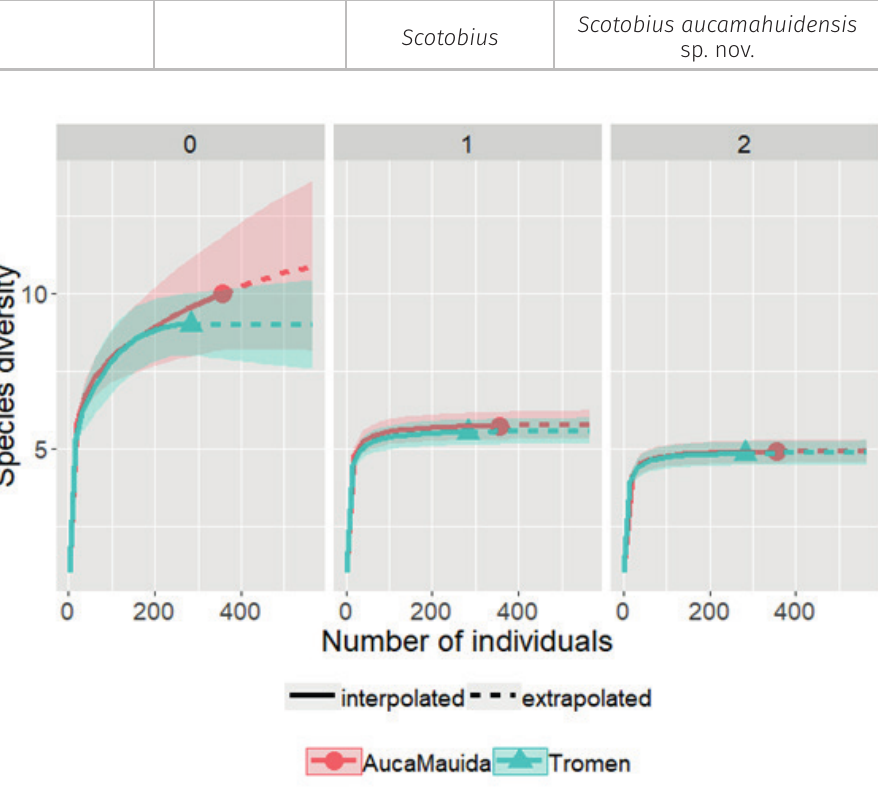
Figure 2. Species accumulation curves used to compare species diversity corrected by different number of individuals between volcanoes: 0) showing species richness; 1) showing Shannon index